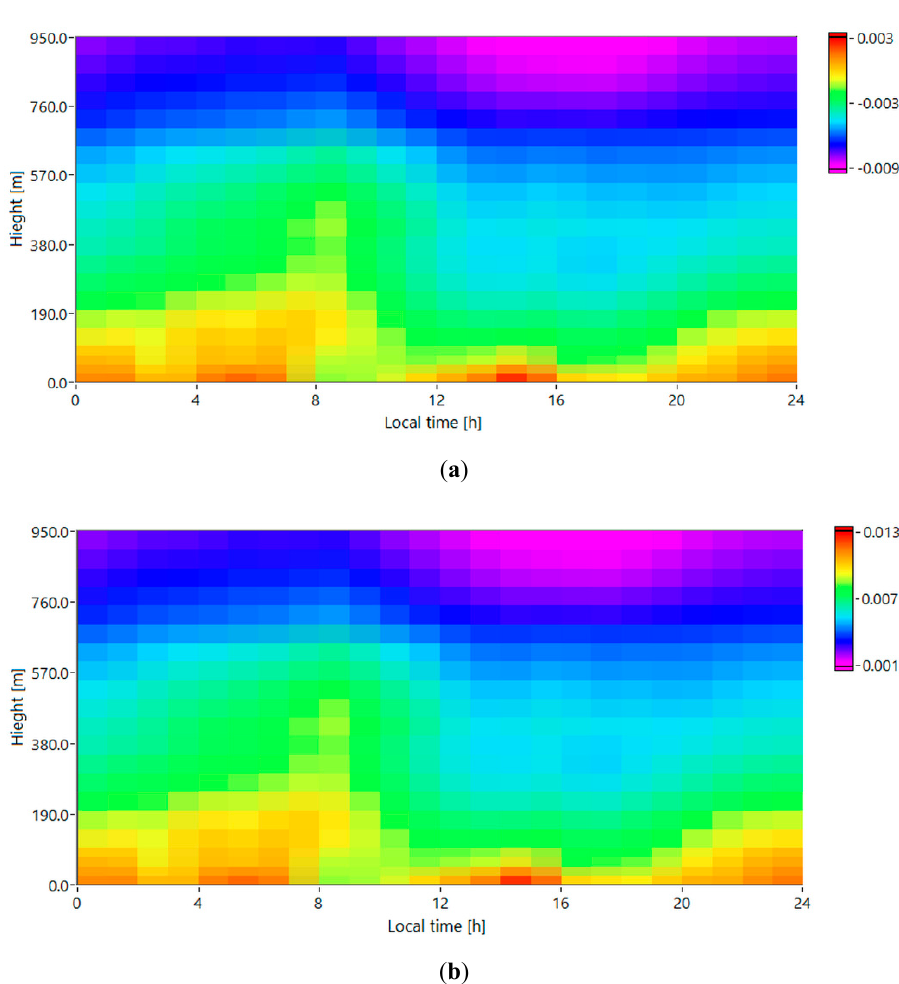
Figure 4. Diurnal variations of the vertical gradients of (a) temperature and (b) potential temperature averaged for the period of measurements on 6–23 August